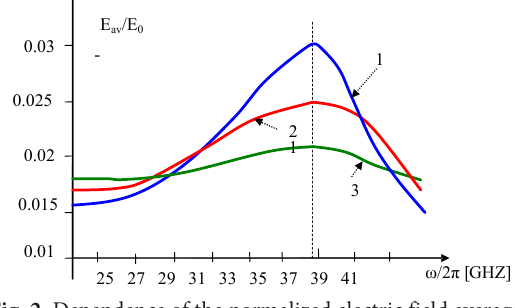
Fig. 2. Dependence of the normalized electric field averaged over the seed volume on the frequency of the exciting electromagnetic wave with the modulation frequency: 1 – Ω=100 Hz; 2 – Ω=50 Hz; 3 – Ω=20 Hz